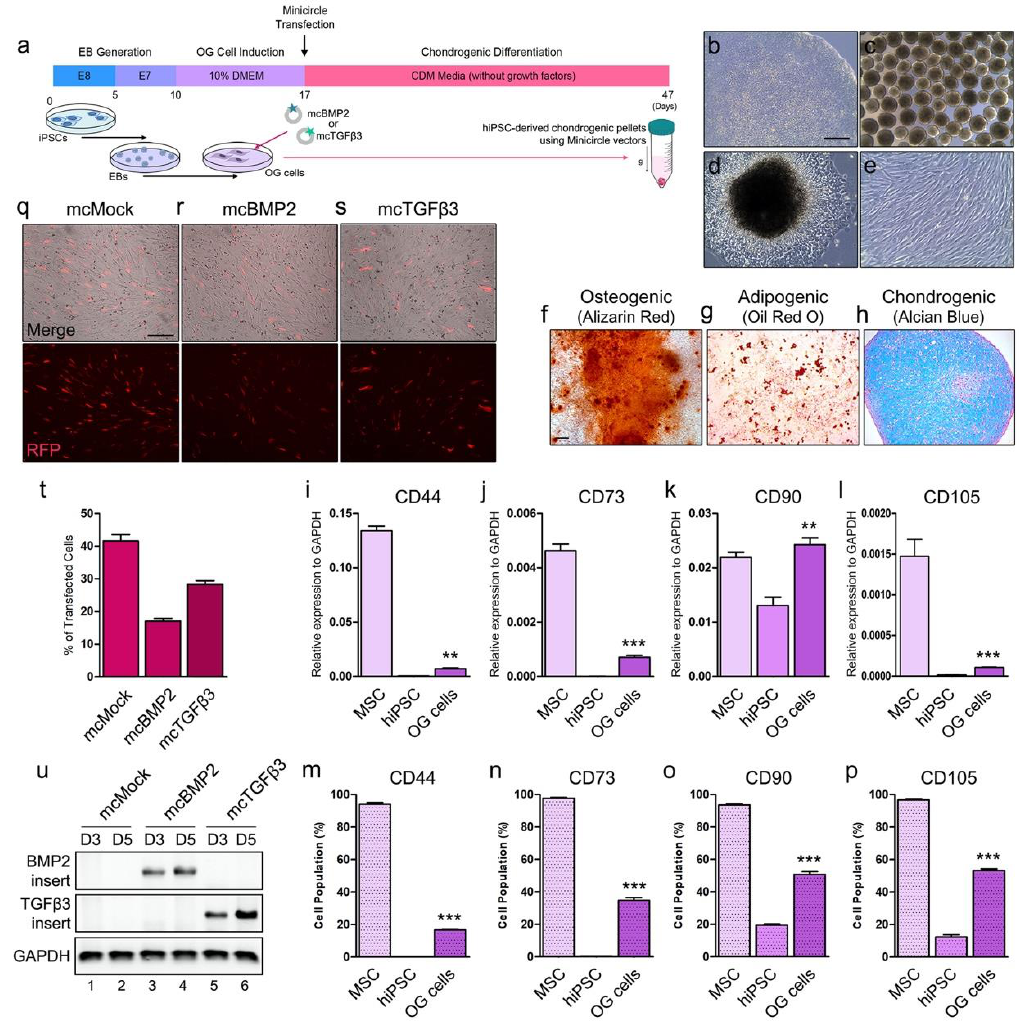
Figure 2. Chondrogenesis using minicircle-transfected hiPSC-derived OG cells. ( a ) Scheme of chondrogenic differentiation process from hiPSCs. Minicircles were transfected after OG cells were induced. ( b ) Morphology of the hiPSC colony. ( c ) Morphology of the generated EBs. ( d ) Image of outgrowth cells derived from EBs attached to a gelatin-coated culture dish. ( e ) Morphology of OG cells before transfection. ( f ) Alizarin red-stained osteogenic cells differentiated from OG cells. ( g ) Oil red O staining image of adipogenic cells differentiated from OG cells. ( h ) Chondrogenic pellet generated from OG cells stained with alcian blue. Relative gene expression of ( i ) CD44, ( j ) CD73, ( k ) CD90, and ( l ) CD105 in OG cells. Percentage of ( m ) CD44, ( n ) CD73, ( o ) CD90, and ( p ) CD105 positive cells. ( q ) Fluorescence microscopy of mcMock-transfected OG cells. ( r ) Fluorescence microscopy of mcBMP2-transfected OG cells. ( s ) Fluorescence microscopy of mc TGFβ 3-transfected OG cells. ( t ) Percentage of OG cells transfected with each minicircle vectors. ( u ) Gel image of the PCR results against the insert of mcBMP2 and mcTGF β 3 in transfected OG cells. Data are presented as mean ± standard deviation from three independent sets of experiments. Scale bars represents 200 µ m. ** p < 0.01 and *** p < 0.001 indicate statistical significance. EB: embryonic body; OG: outgrowth; CDM: chondrogenic di ff erentiation media; RFP: red fluorescence protein; MSC: mesenchymal stem cell; hiPSC: human induced pluripotent stem cell; mcMock: minicircle mock vector-transfected outgrowth cells; mcBMP2: minicircle BMP2-encoding vector-transfected outgrowth cells; mcTGF β 3: minicircle TGF β 3-encoding vector-transfected outgrowth cells.